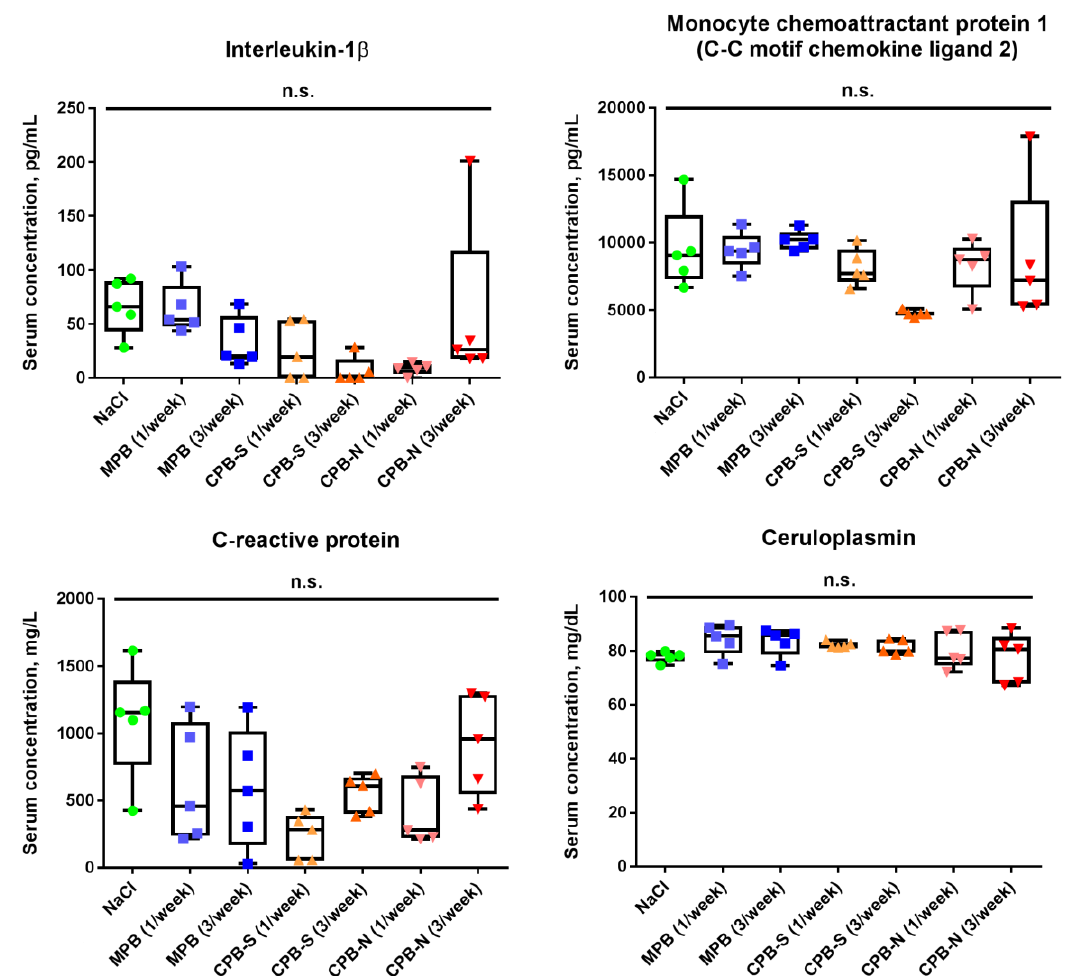
Figure 5. Quantification of serum pro-inflammatory cytokines (interleukin- 1β and monocyte chemoattractant protein 1/C-C motif chemokine ligand 2) and acute phase proteins (C-reactive protein and ceruloplasmin) in Wistar rats treated with NaCl, MPB, CPB-S, or CPB-N according to the indicated protocol. Box-and-whisker plots combined with a univariate scatterplot, where each dot represents a serum sample collected from one rat. Whiskers indicate range, box bounds indicate the 25th and 75th percentiles, and center lines indicate the median. Dunn’s multiple comparisons test, n.s. is for